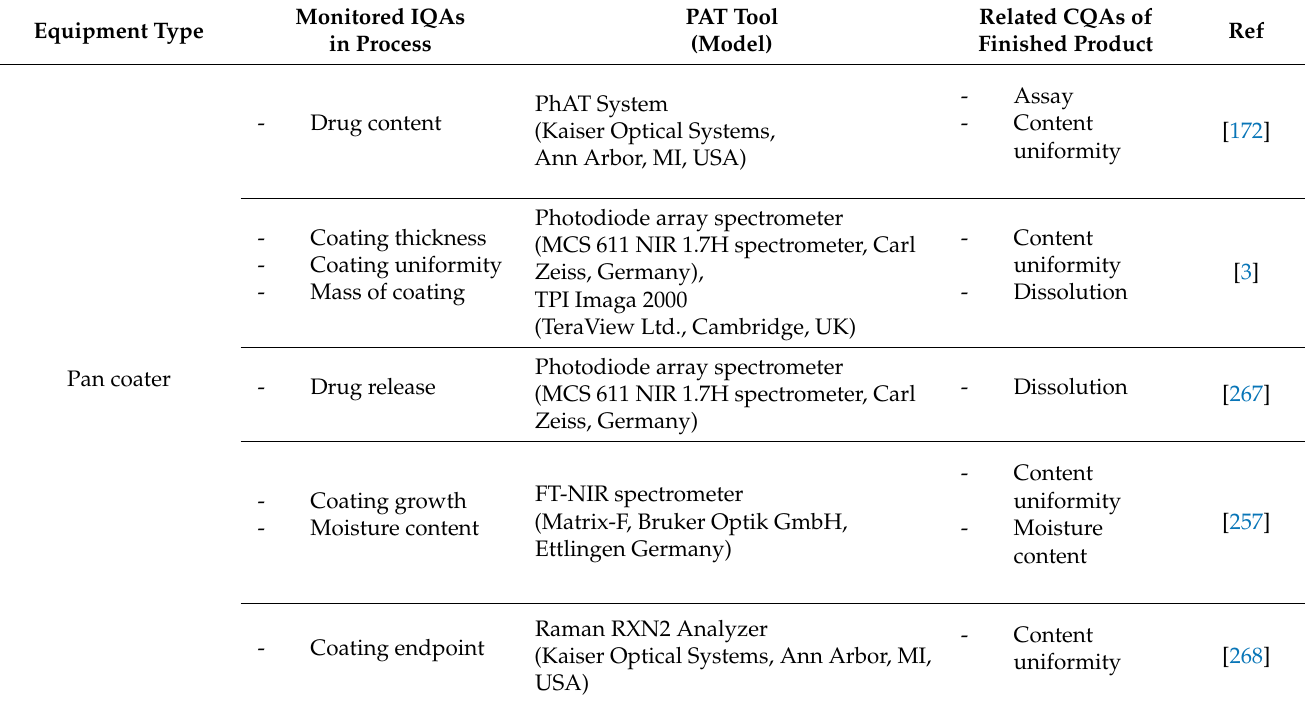
Figure 4. Schematic diagram showing the correlation between the coating thickness and the dissolution rate by analyzing the coating thickness of the tablet by applying a hyperspectral imaging system to the coating process [261]. Reproduced with permission from Louise Ho, Journal of Controlled Release; published by Elsevier, 2008. Table 5. Summary of PAT-based modeling method applied in coating